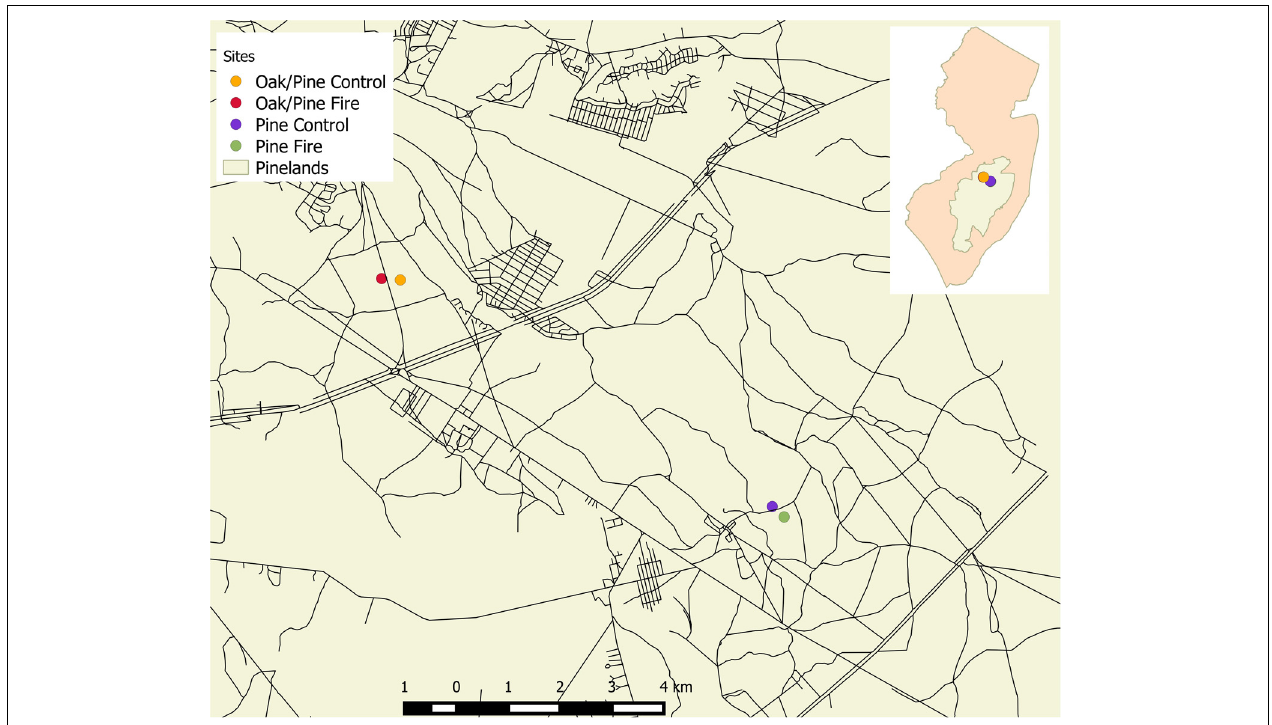
FIGURE 1 | Map of New Jersey (insert) with the New Jersey Pine Barrens highlighted in the center. Large map shows the oak/pine sites and the pine site. The long-term site is designated in orange (see also description in